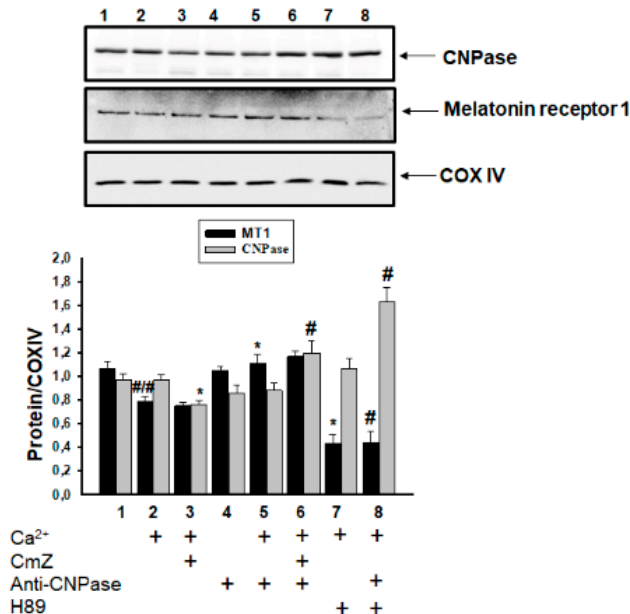
Figure 5. Effect of CmZ, H89, and anti-CNPase antibody, and their combined effect on the level of MT1 and CNPase in RBM. Upper part—western blot of a mitochondrial suspension after the isolation of RBM (see Materials and methods). Membranes were stained with antibody specific to Melatonin receptor A1 (MT1) and CNPase. Lower part—quantitation of immunostaining using computer-assisted densitometry. Bar graphs represent the immunoreactivity of MEL MT1 receptor and CNPase in RBM after the addition of CmZ (30 μ M), H89 (5 μ M), and anti-CNPase antibody (0.18 μ g/mL). The protein band intensity was quantified after normalization with respect to COX IV. The values shown are the means ± SD from three independent experiments; #/# p ≤ 0.05 vs. MT1 level in in control conditions without any additions, * p ≤ 0.05 vs. the MT1 and CNPase levels in the presence of Ca 2+ . # p ≤ 0.05 vs. MT1 and CNPase levels in the presence of anti-CNPase antibody and Ca 2+ .